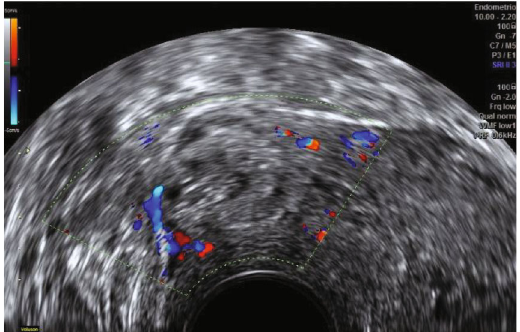
Figure 4: The color Doppler study showed